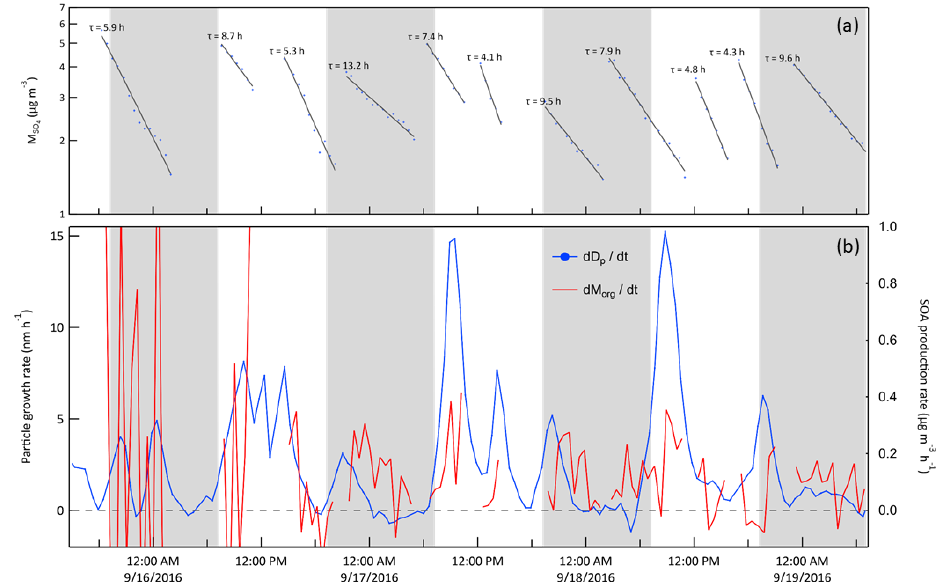
Figure 15. (a) Sulfate mass concentration in Chamber A measured with the HR-ToF-AMS during the same 3.5d example period as in Figs. 10, 11, and 12. The lines and time constants are for the exponential decay fits to the concentrations. (b) Averaged diameter growth rate from Fig. 12 (blue) and calculated rate of change of organic aerosol mass concentration (red). The rate of change of the organic mass concentration was corrected for loss using the sulfate mass using Eq. (2). The contrast between the two highlights the challenge in quantifying secondary aerosol production under ambient conditions using measurements of aerosol volume or mass concentration and motivates instead tracking narrow size distribution modes. The shaded bands represent nighttime.